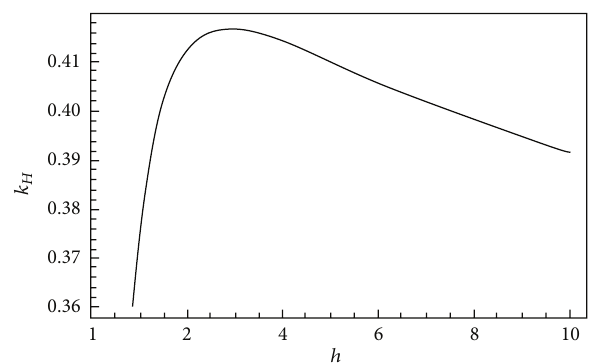
Figure 3: Theoretical dependence of the Huggins coefficient on the draining parameter ℎ , calculated from